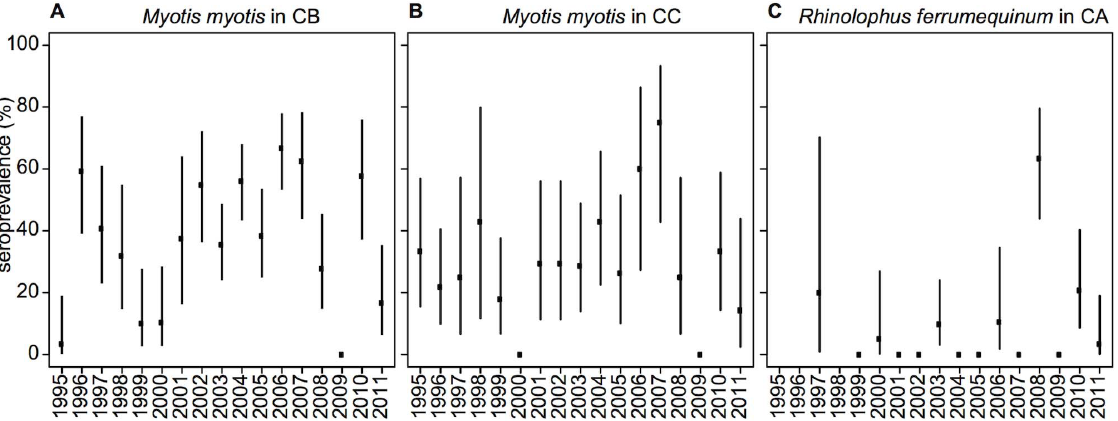
Figure 2. EBLV-1 seroprevalence by subpopulation. Observed EBLV-1 seroprevalences with 95% CI in two Myotis myotis colonies (A, B) and one Rhinolophus ferrumequinum colony (C). Null rates of seroprevalence at some times might not be indicative of local virus extinctions, but just virus extinctions in that subpopulation or a consequence of under-reporting.